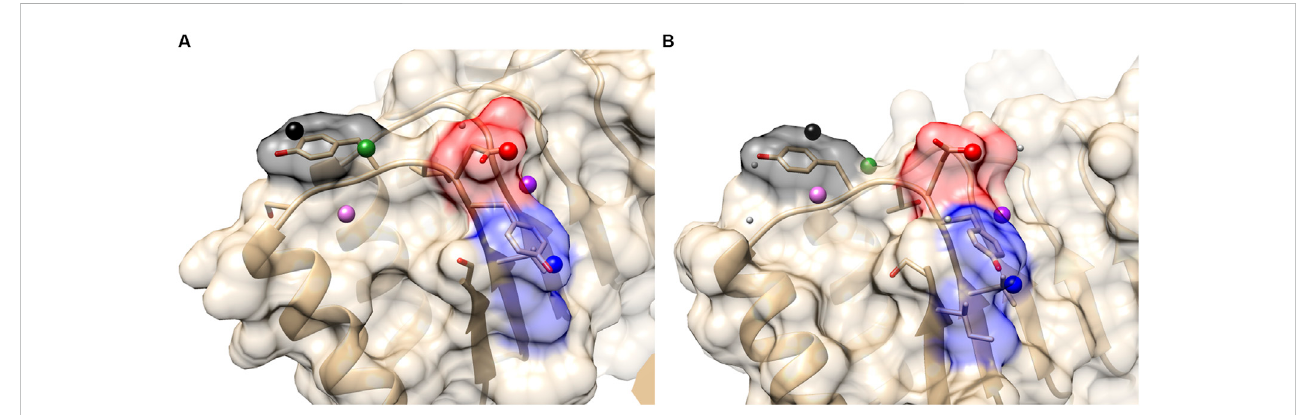
FIGURE 7 Hotspot patches in two ribonuclease inhibitors (RIs), which were identi fi ed by PPI-Surfer. (A) , 1a4yA. Three hotspot residues, TYR434, ASP435, and TYR437areshowninthestickrepresentation. (B) ,1dfjB.Thethreehotspotresidues,TYR430,ASP431,andTYR433areshowninthestickrepresentation.These two receptors have a sequence identity of 77%. The seed points of six corresponding patch pairs identi fi ed by PPI-Surfer are shown in spheres in the same colors. In addition, other seeds of hot spot patches are shown with light gray spheres. The three lowest pDist patch pairs and their surfaces are colored black, red, and blue.